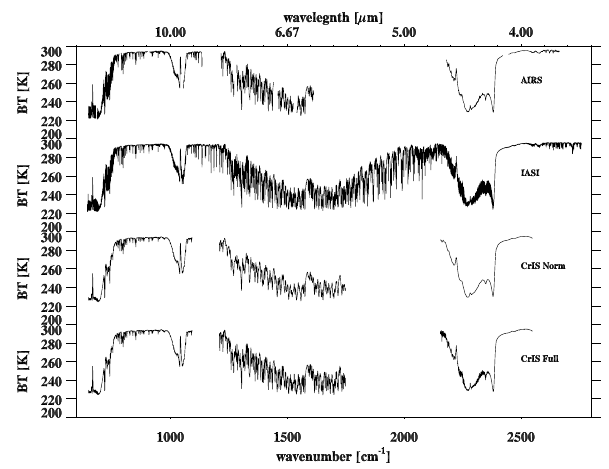
Figure 1. AIRS, CrIS, and IASI spectra simulated by LBLRTM using an identical tropical atmospheric profile over the ocean. The description of CrIS normal and full spectral resolution mode can be found in the